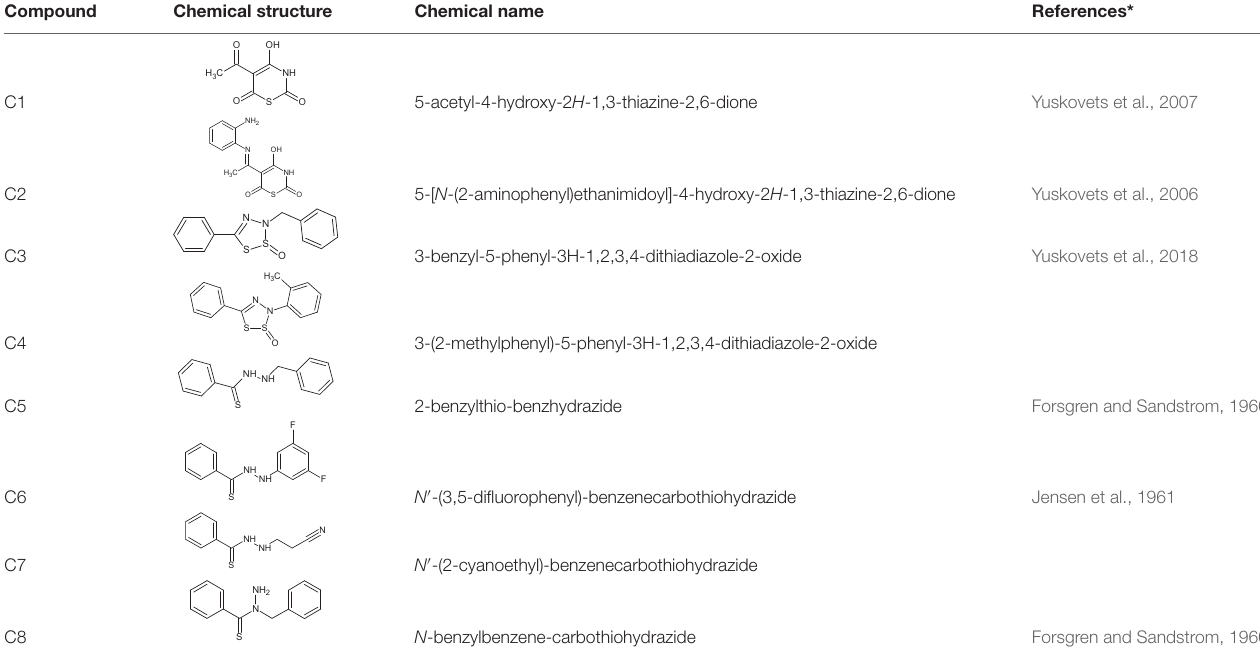
TABLE 1 | Chemical structure of the tested 1,3-thiazine, 1,2,3,4-dithiadiazole, and thiohydrazide